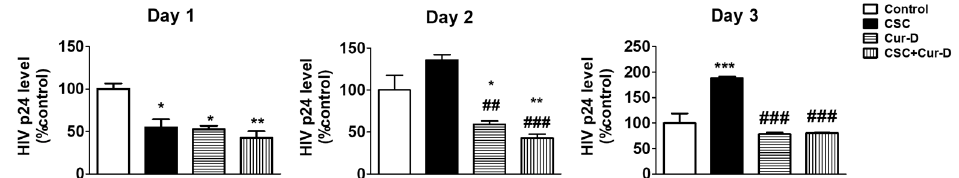
Figure 5. Effect of Cur-D on CSC-induced HIV replication: Differentiated U1 macrophages were concomitantly treated with CSC (10 µg/mL) and Cur-D (0.1 µM) every day for 3 days. HIV p24 levels were measured at the end of the treatment using an ELISA kit. One-way ANOVA with Tukey’s post-hoc test was applied to compare between multiple groups. *, **, and *** represent p < 0.05, p ≤ 0.01, and p ≤ 0.001, respectively when compared to control. ##, and ### represent p ≤ 0.01, and p ≤ 0.001, respectively when compared to CSC.